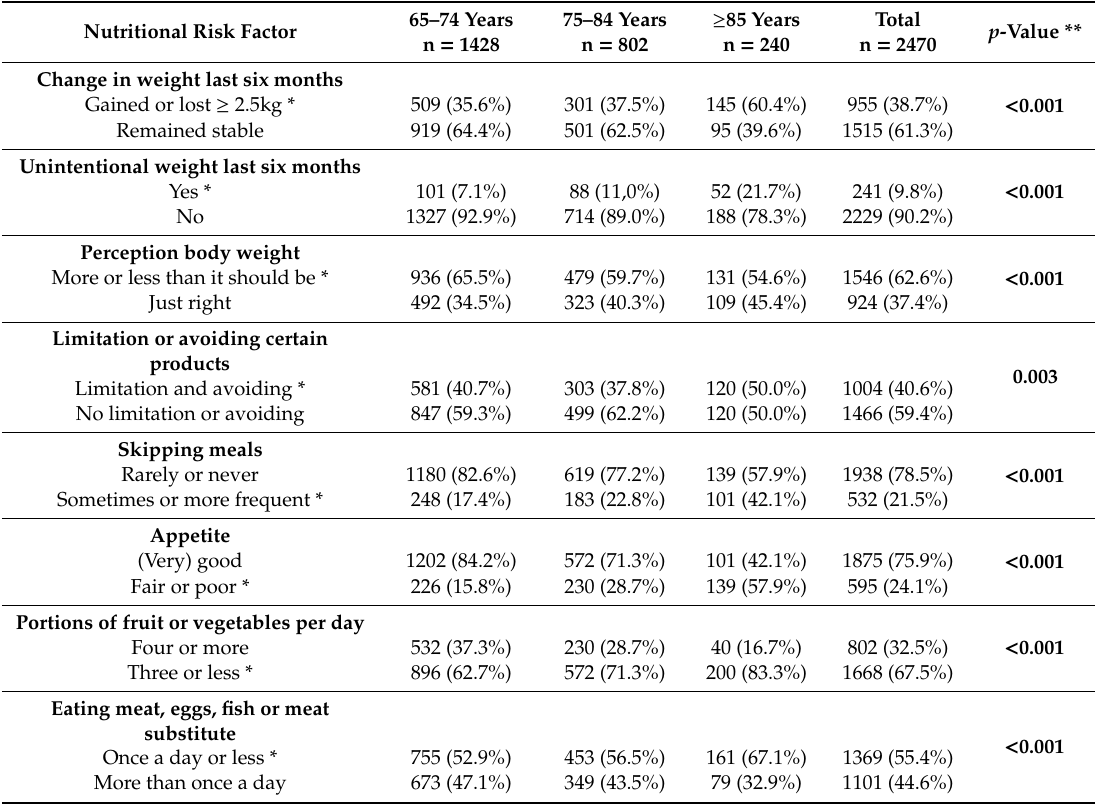
Table 2. Nutritional risk factors according to the 17 questions of SCREEN II, compared between age